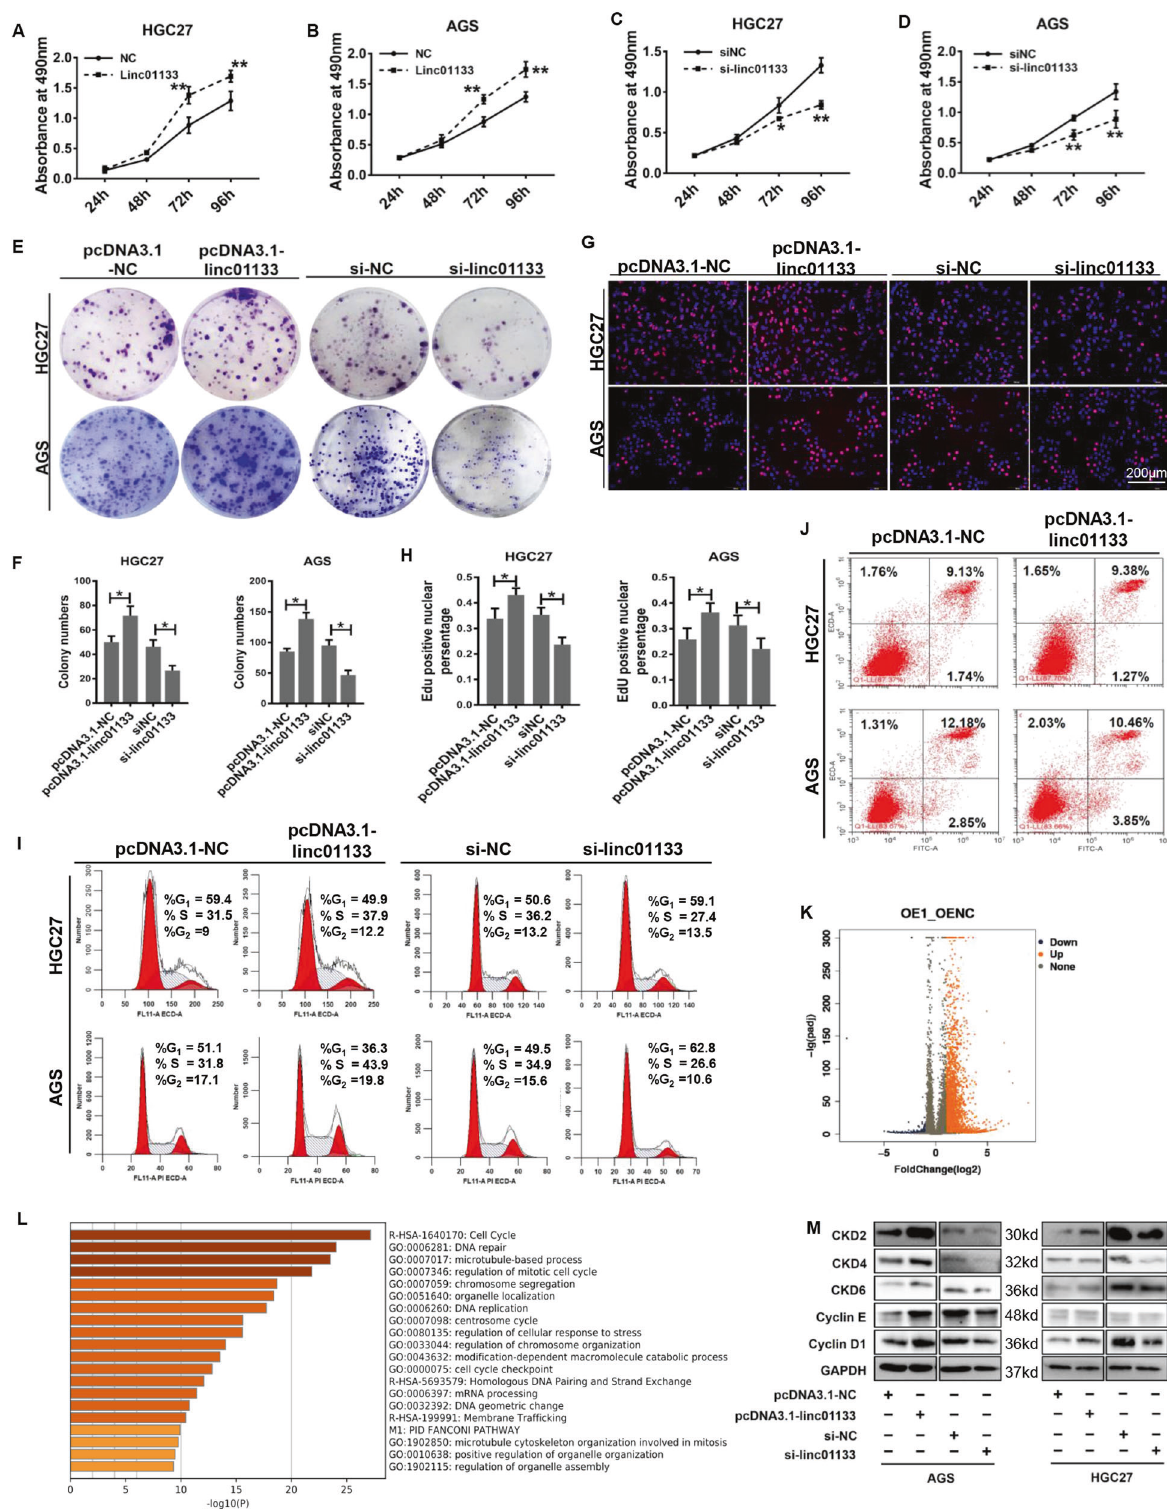
Fig. 2 Linc01133 promotes the growth and cell-cycle transition of tumor cells in vitro. A – D Overexpression of linc01133 increased while knocking-down linc01133 decreased the cell viability by MTS assay. E , F Colony formation assays shows increased and decreased numbers of colonies formed by linc01133 manipulation. G , H EdU assay shows the increased and decreased proliferating cells upon linc01133 overexpression or knocking- down. I Flow cytometry shows that linc01133 greatly increased the S phase cells and decreased the G0/G1 phase cells. J linc01133 has no impact on cell apoptosis. K Volcano plot shows the up and downregulated genes upon linc01133 overexpression by RNA-seq. L Gene ontology analysis using online tool Metascape shows that cell cycle and cell cycle checkpoint pathways were enriched. M Western blots show that linc01133 increased the expression of G1 to S phase transition related genes. Each experiment was performed in triplicates. Data are shown as mean±SD, * P <0.05, ** P <0.01.